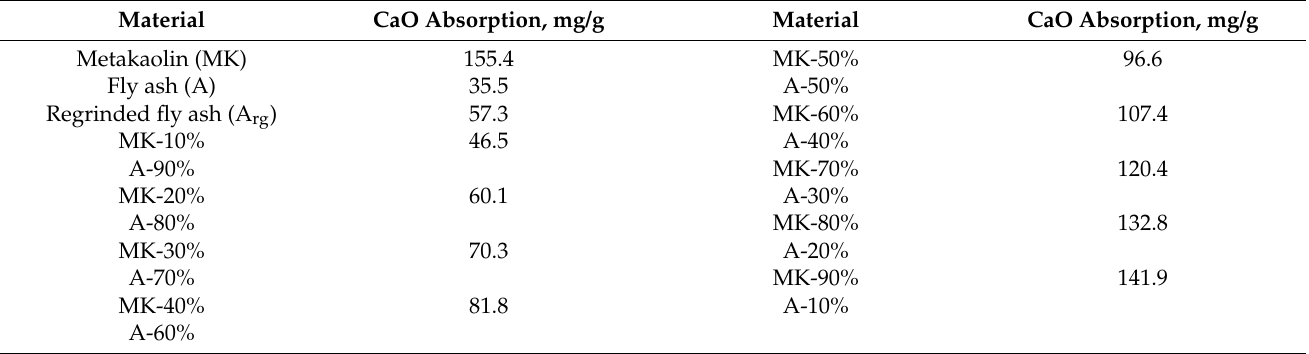
Table 2. Pozzolanic activity of MK, fly ash and their